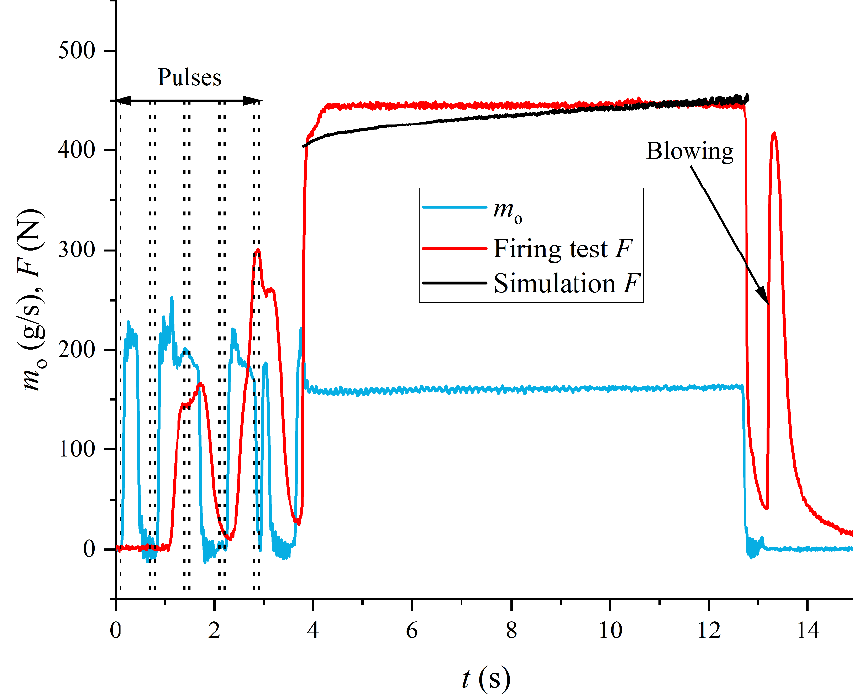
Figure 15. The results of the firing test and simulation.